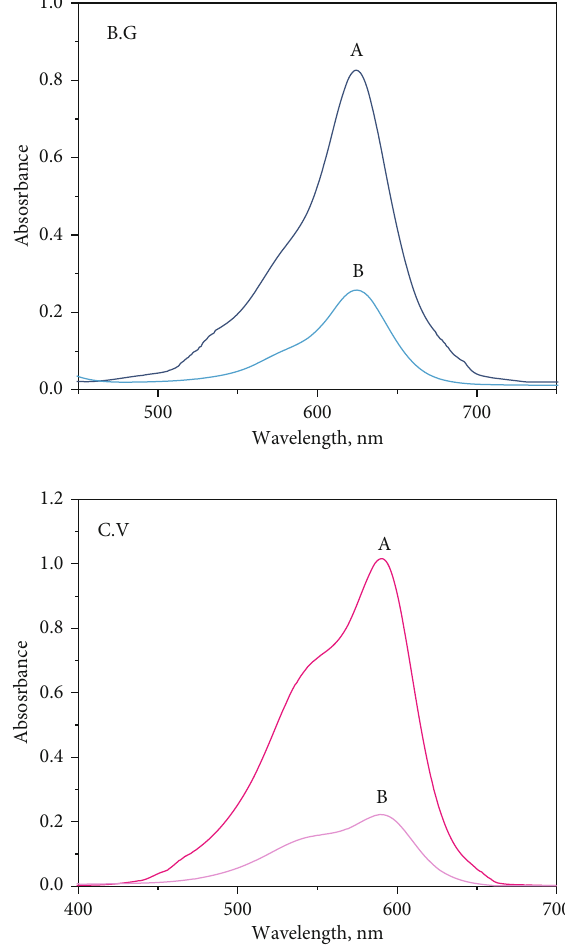
Figure 6: The electronic spectrum of B.G. dye and C.V. dye in the aqueous phase in the absence of solid phase (a) and after adding solid-phase binary P3NT/30%AgTiO mins (b).